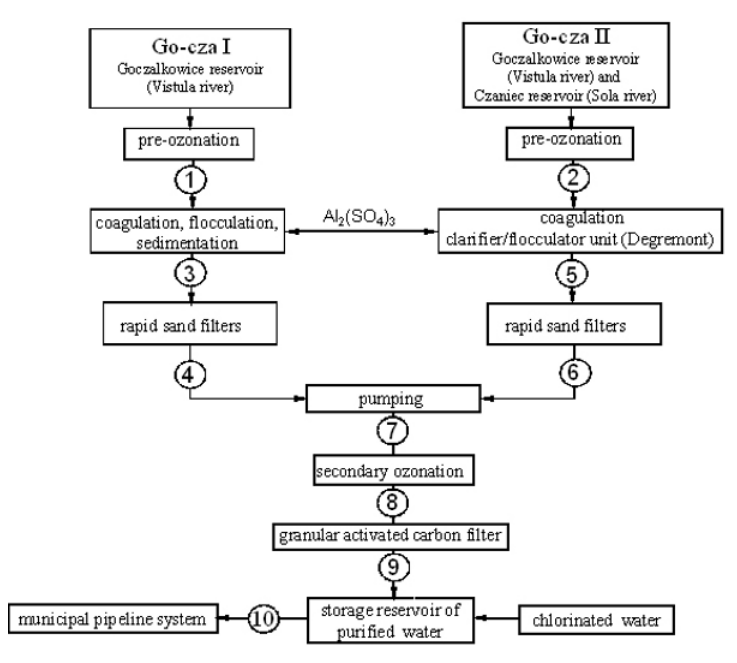
Figure 1. Flowchart of the stages of water purification in Water Treatment Plant